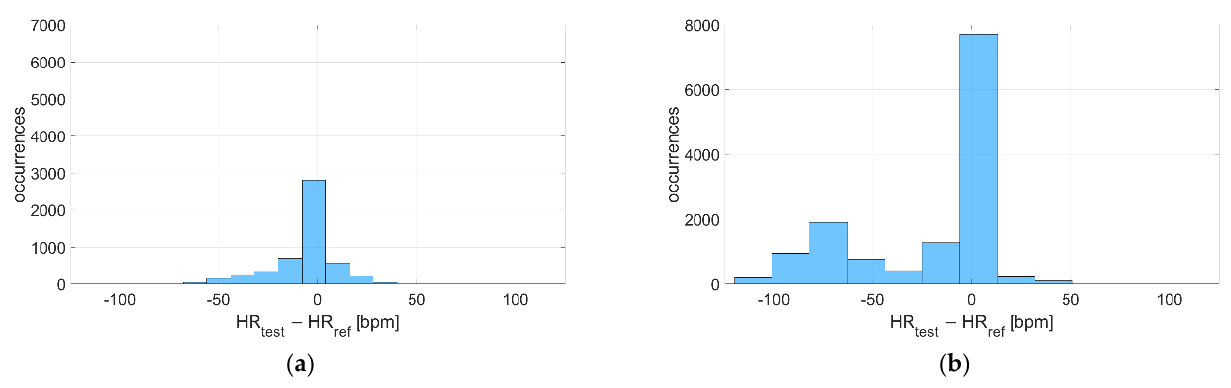
Figure 13. Distribution of deviations related to ( a ) Resting and ( b ) During activities, including recordings both at in-water and dry conditions performed with Garmin Venu Sq (reference instrument: Polar H10).